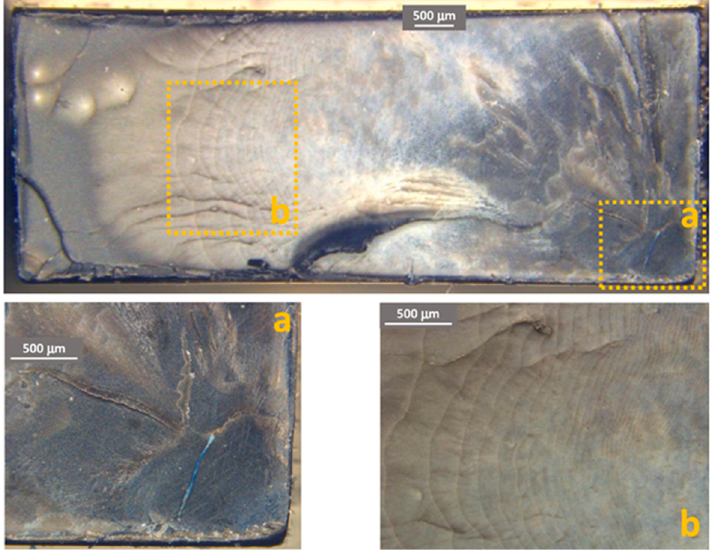
Figure 15. ABS fracture surface after test at 85 °C. ( a ) Crack initiation point; ( b ) propagation beach marks.